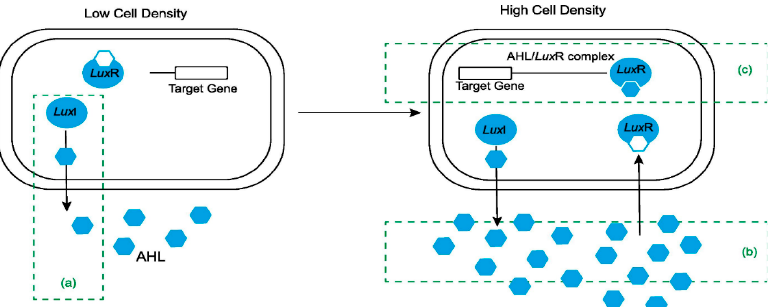
Figure 2. Inhibition of quorum sensing in Gram-negative bacteria: ( a ) inhibition of AHL synthesis; ( b ) degradation of AI using enzymes; ( c ) interference with signal receptors (From [8] with permission from Elsevier; license number: 5433491396764).